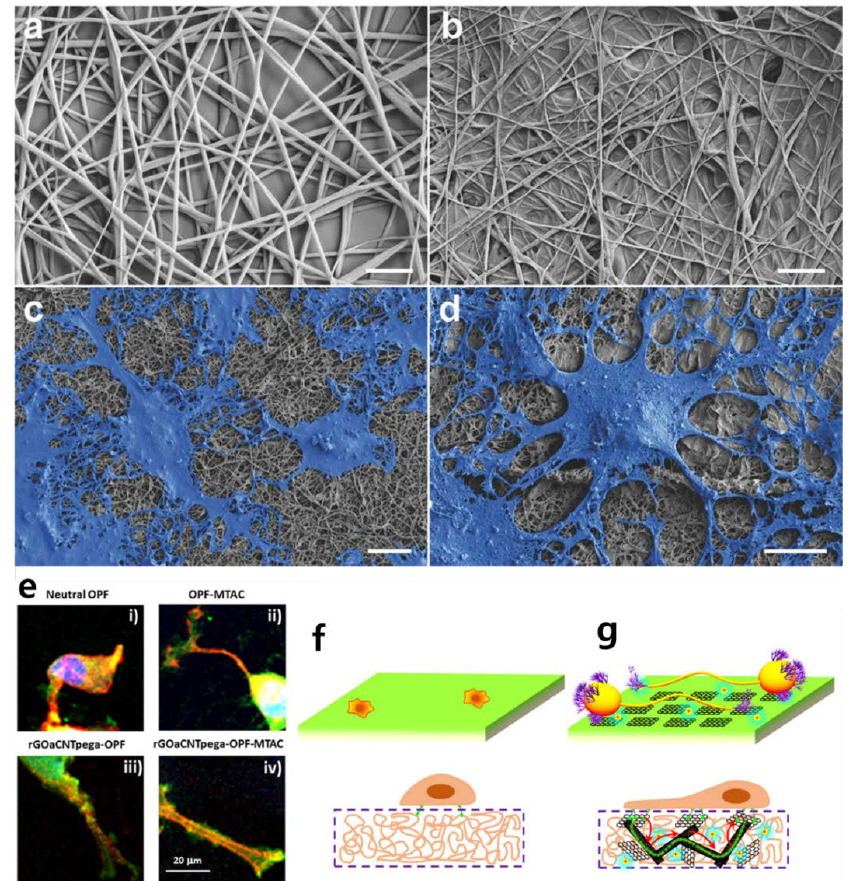
Figure 3. Scanning electron microscopy images of ( a ) polycaprolactone (PCL) nanofibers, ( b ) PCL nanofibers coated with graphene oxide (GO), ( c ) differentiated neural stem cells (NSCs) on PCL